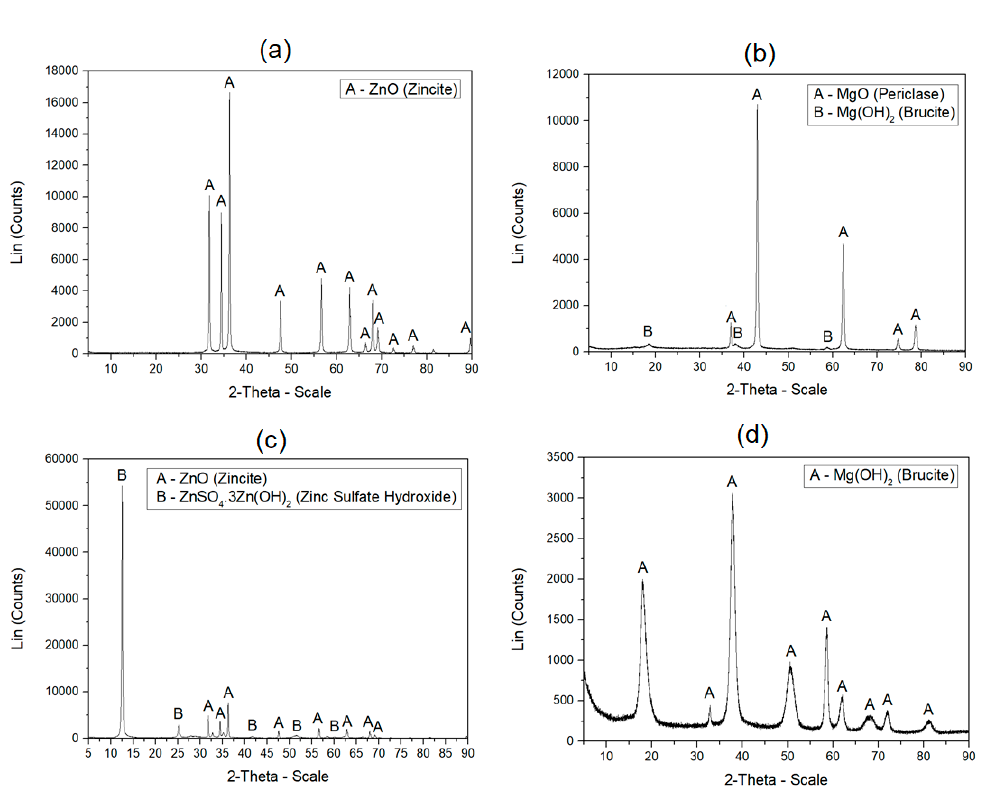
Figure 1. XRD patterns of inorganic nanoparticles: ( a ) originally supplied ZnO; ( b ) originally supplied MgO; ( c ) ZnO affected by polymerization conditions; ( d ) MgO affected by polymerization conditions.